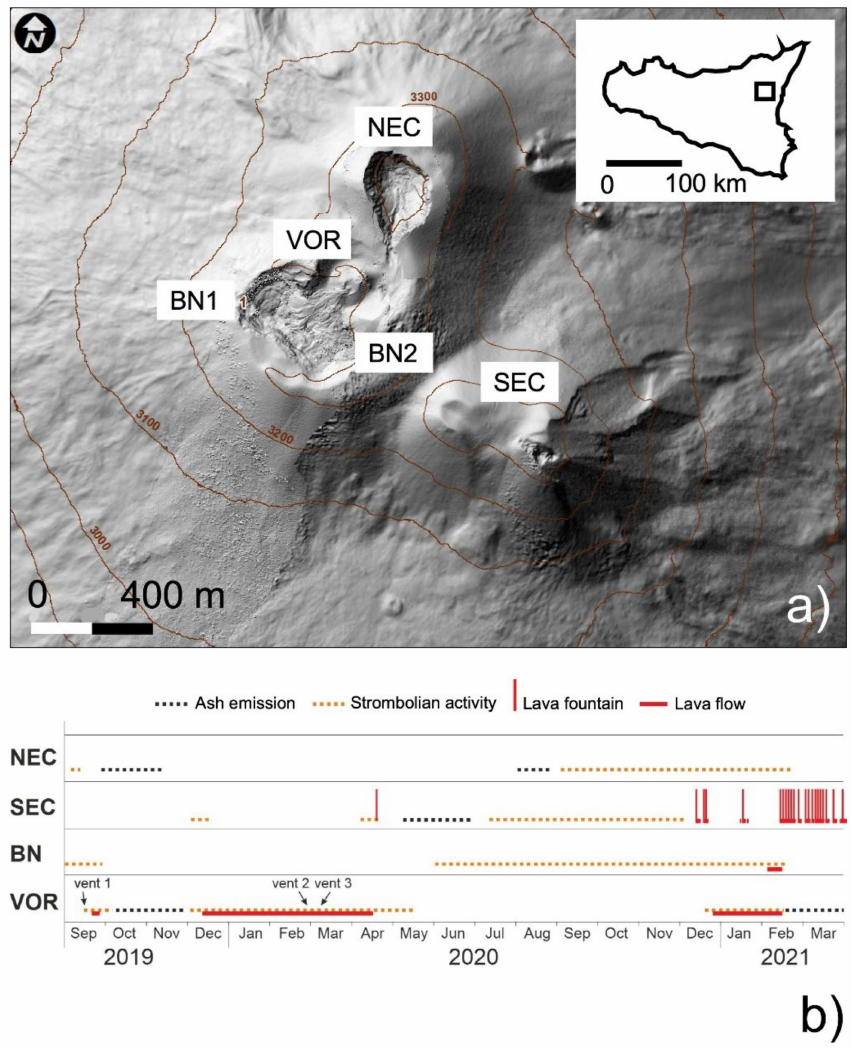
Figure 1. ( a ) Map of Etna summit craters, with a map of Sicily in the inset. The open square in the map indicates the location of Etna’s summit. ( b ) Graphic timeline of eruptive activity at the summit craters of Etna, September 2019–March 2021. NEC = Northeast Crater; SEC = Southeast Crater; BN = Bocca Nuova; VOR = Voragine. Vent 1, vent 2, and vent 3 denote dates on which the three